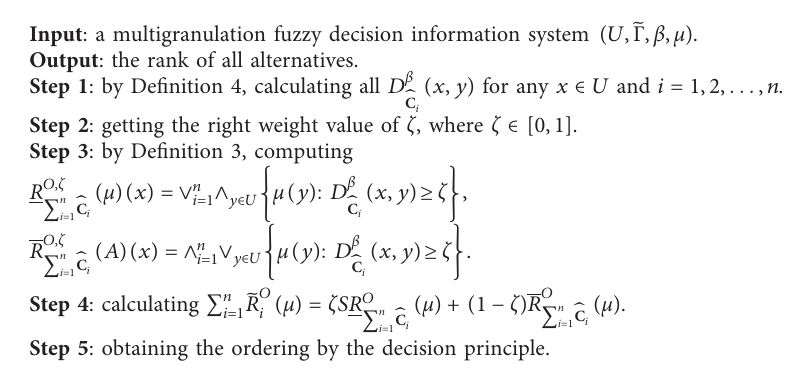
A LGORITHM 3: An algorithm for the problem of MCGDM. Table 10: The results utilizing the different methods of Example 21. Methods The final ranking The patients are more likely to be sicken for the disease A Algorithm 1 (Zhan et al.